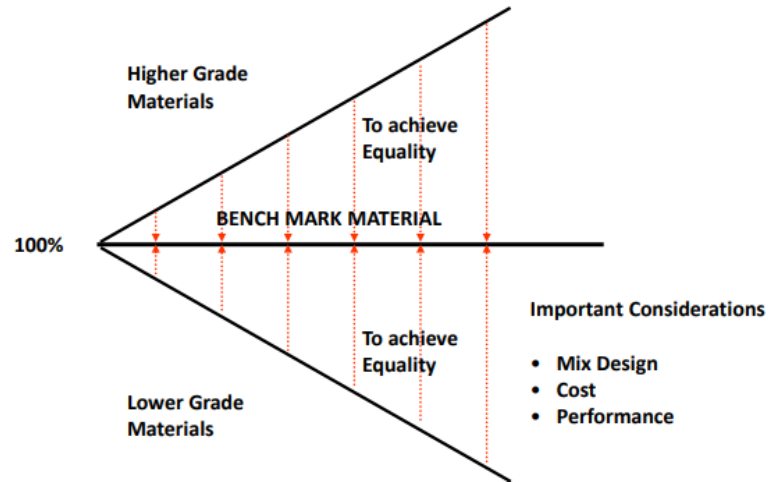
Figure 6. Benchmark materials towards a sustainable construction practice [34,47,48].